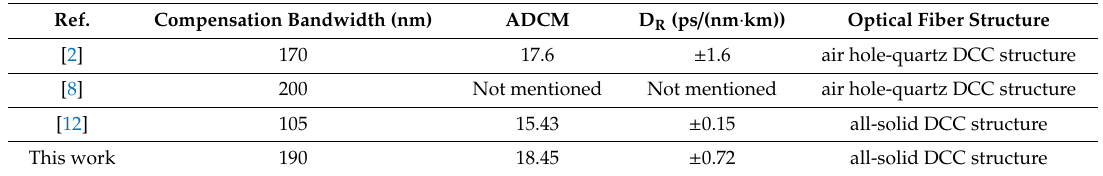
Table 3. Comparison with the reported